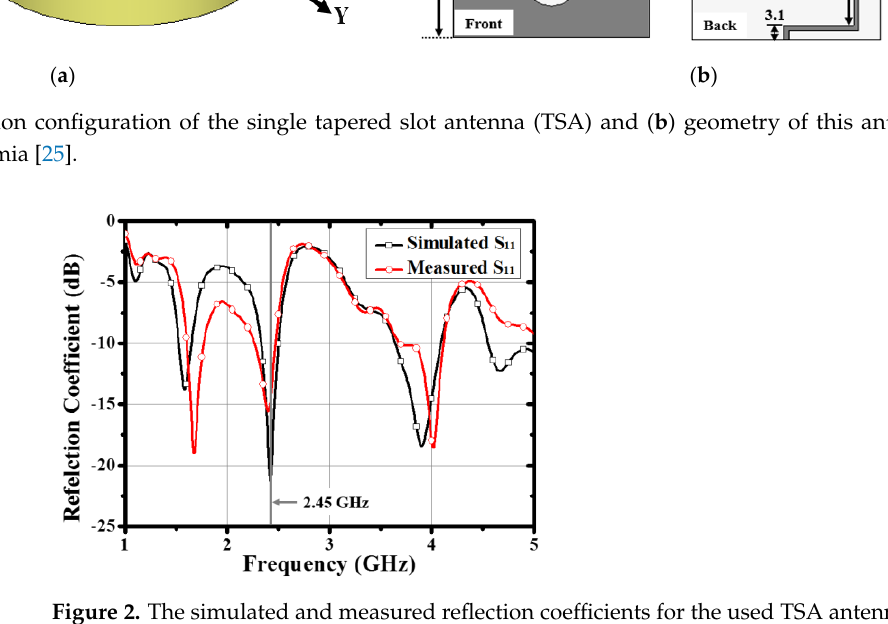
Figure 3. Simulated E-field distribution at 2.45 GHz in the breast phantom derived from a single TSA antenna. 2.2. Antenna Array Configuration for Effective Electric Field Concentration As mentioned in the previous section, the designed TSA antenna is linearly polarized along the radiation direction, and each antenna should be aligned along the surface of the cylindrical phantom for effective E-field synthesis. The number of radiators, which should be determined for the successful E-field concentration on the target area, was set at 12 due to the SAR accumulation in the breast phantom, in accordance with our previous study [25]. The array configurations for inducing microwave hyperthermia along the xz- and xy-planes are presented in Figure 4a,b, respectively. To feed the array antenna, simulta- neous excitation is induced with an EM simulation tool. To apply the input power to each antenna, a discrete port is assigned to each TSA and the open boundary condition in CST is set to analyze the antennas’ performances. The narrowband antennas are arranged at regular intervals for vertical linear polarization along the z-axis. ( a ) ( b ) Figure 4. The 3D model of the cylindrical TSA antenna array with vertical polarization: ( a ) xz-plane and ( b ) xy-plane.